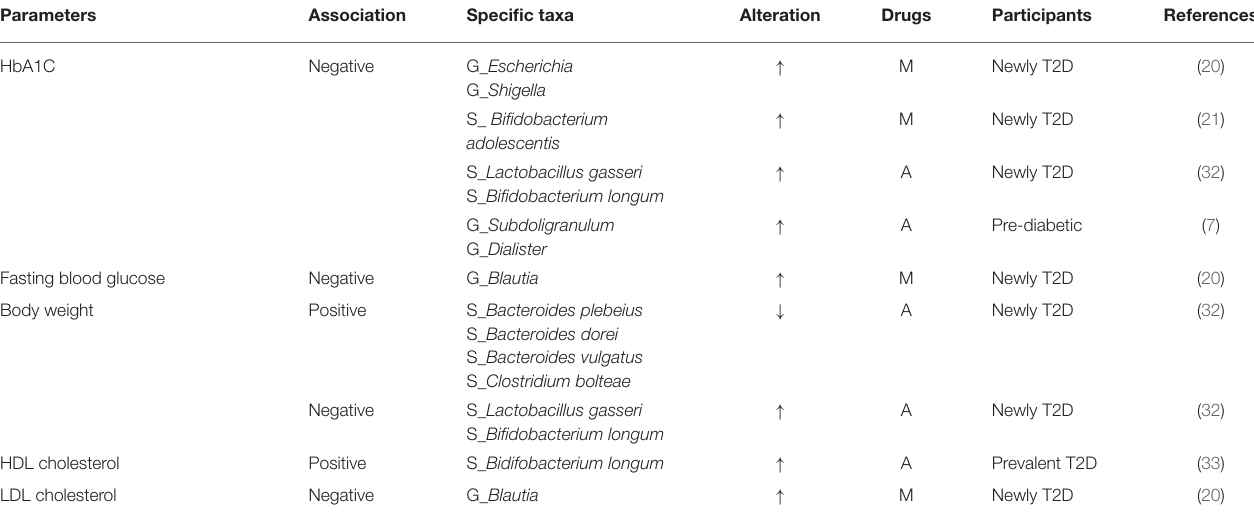
TABLE 10 | Association between specific taxa and human metabolic